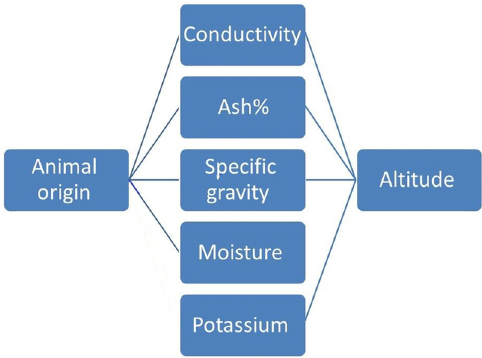
Figure 2: Signi fi cant e ff ects of animal origin and altitude on the studied parameters. According to the multivariate analysis, the conductivity, ash, and speci fi c gravity were signi fi cantly a ff ected by the milk origin and altitude.